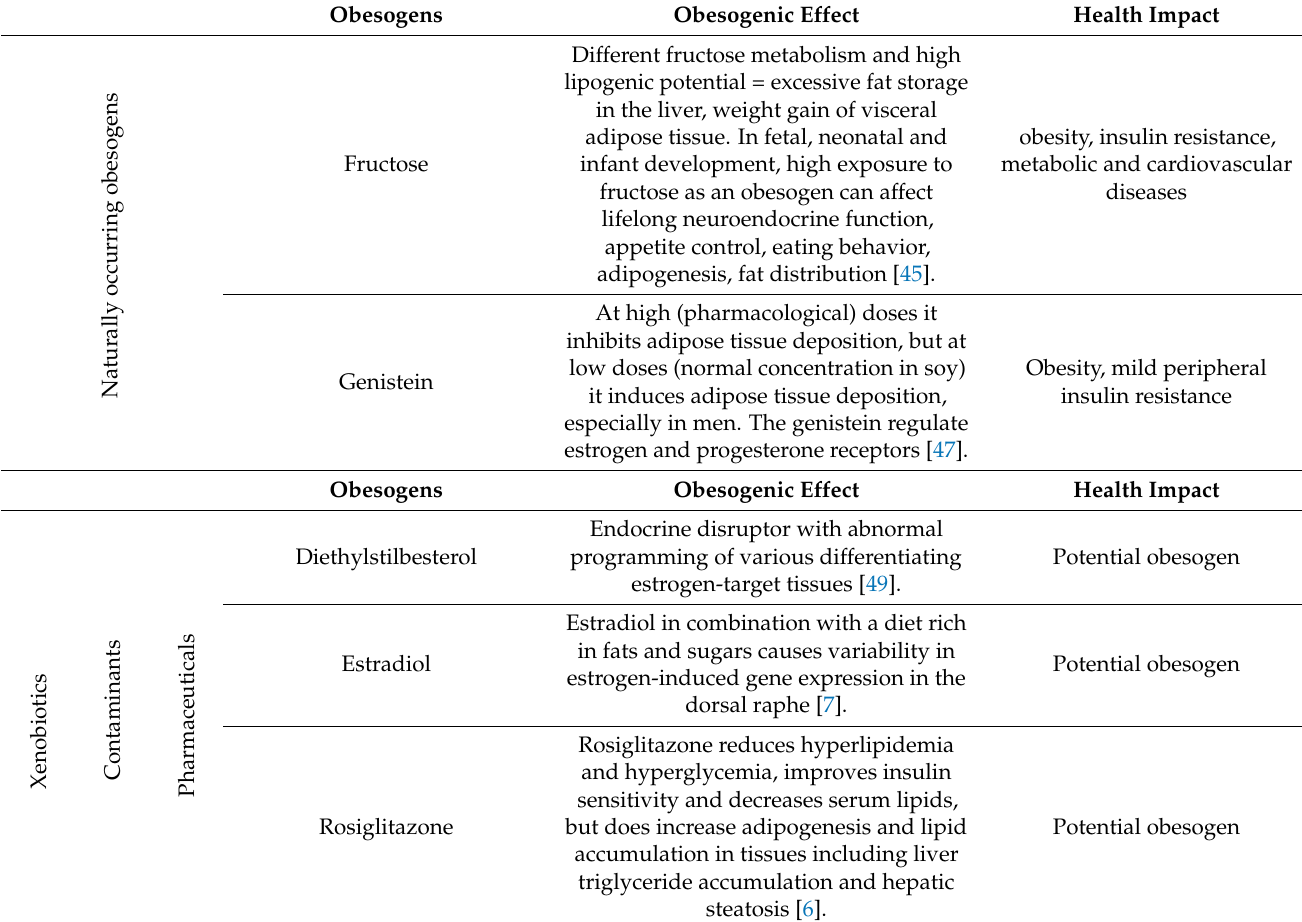
Table 1. Obesogens and their effect on human